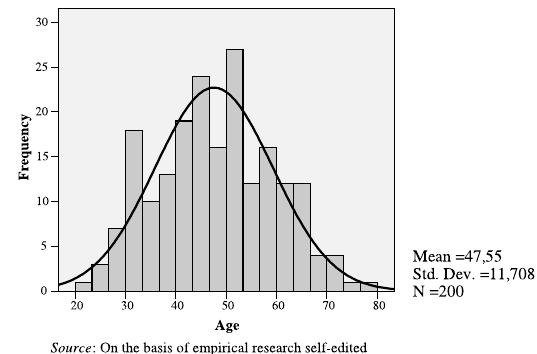
Figure 1. The distribution of involved answerers between different age-groups, regarding the frequency of the valid answers, 2008